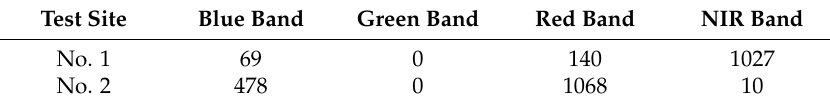
Table 6. Number of the saturation pixels in the GF-4 PMS